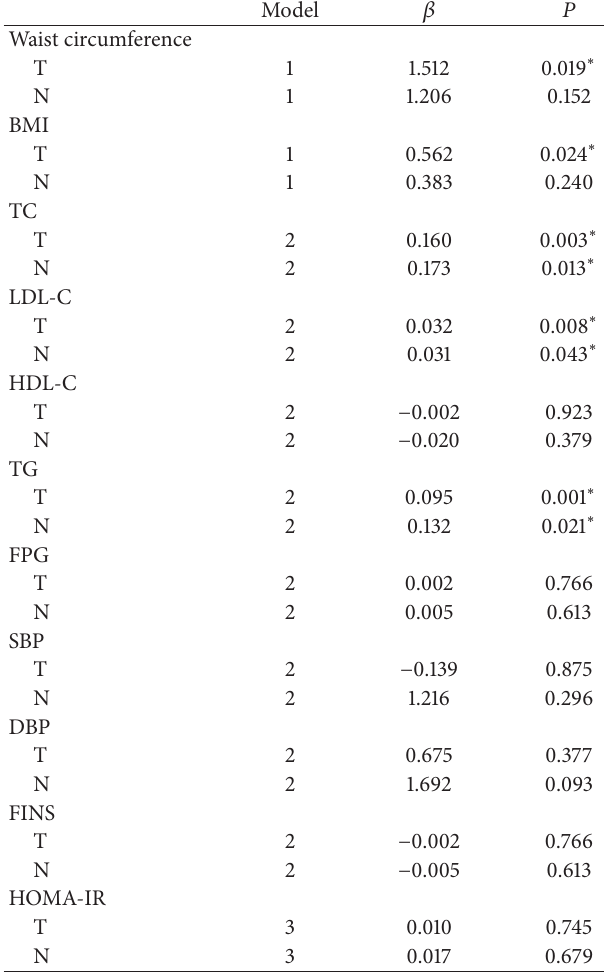
∗ 𝑃 < 0.05 ;valuesof 𝛽 areregressioncoefficients;T:totalTSH;N:TSHwithin normal range; model 1: adjusted for age, gender, and HOMA-IR; model 2: adjusted for age, gender, HOMA-IR, and BMI; model 3: adjusted for age, gender, and